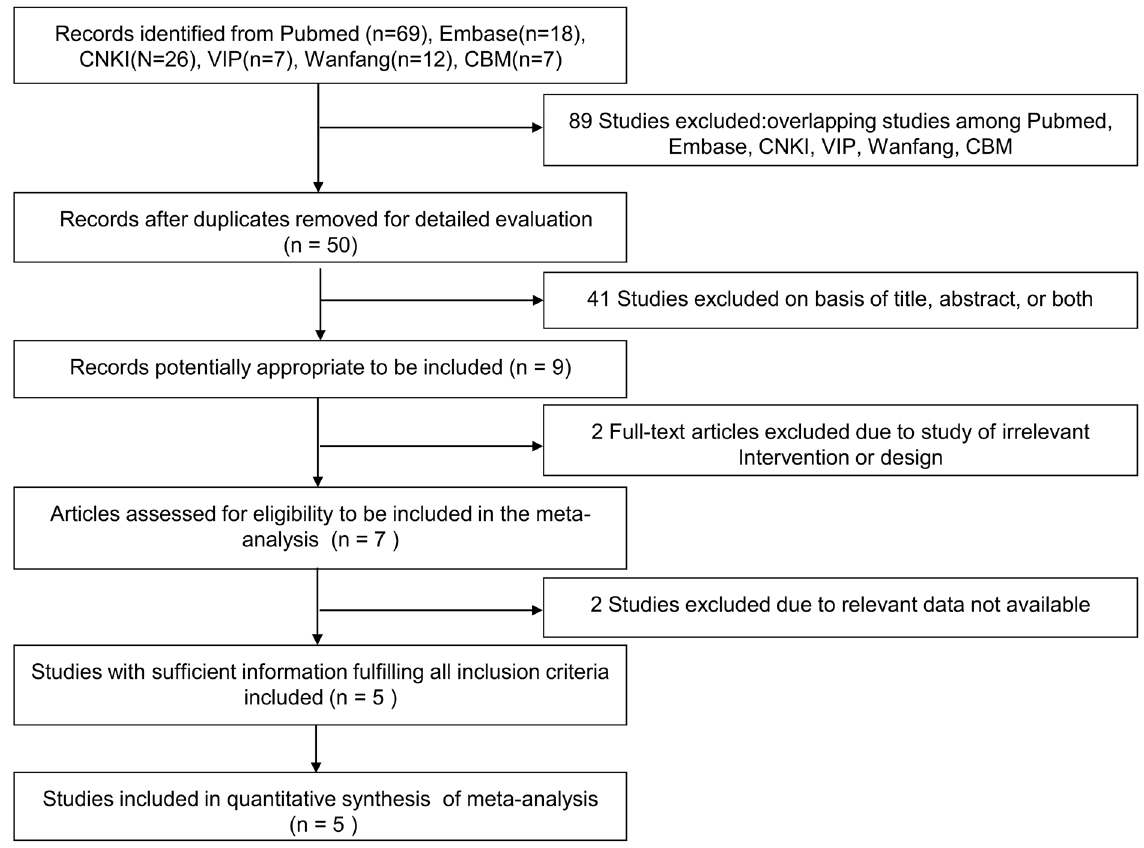
Figure 1. Flow diagram of the study selection.